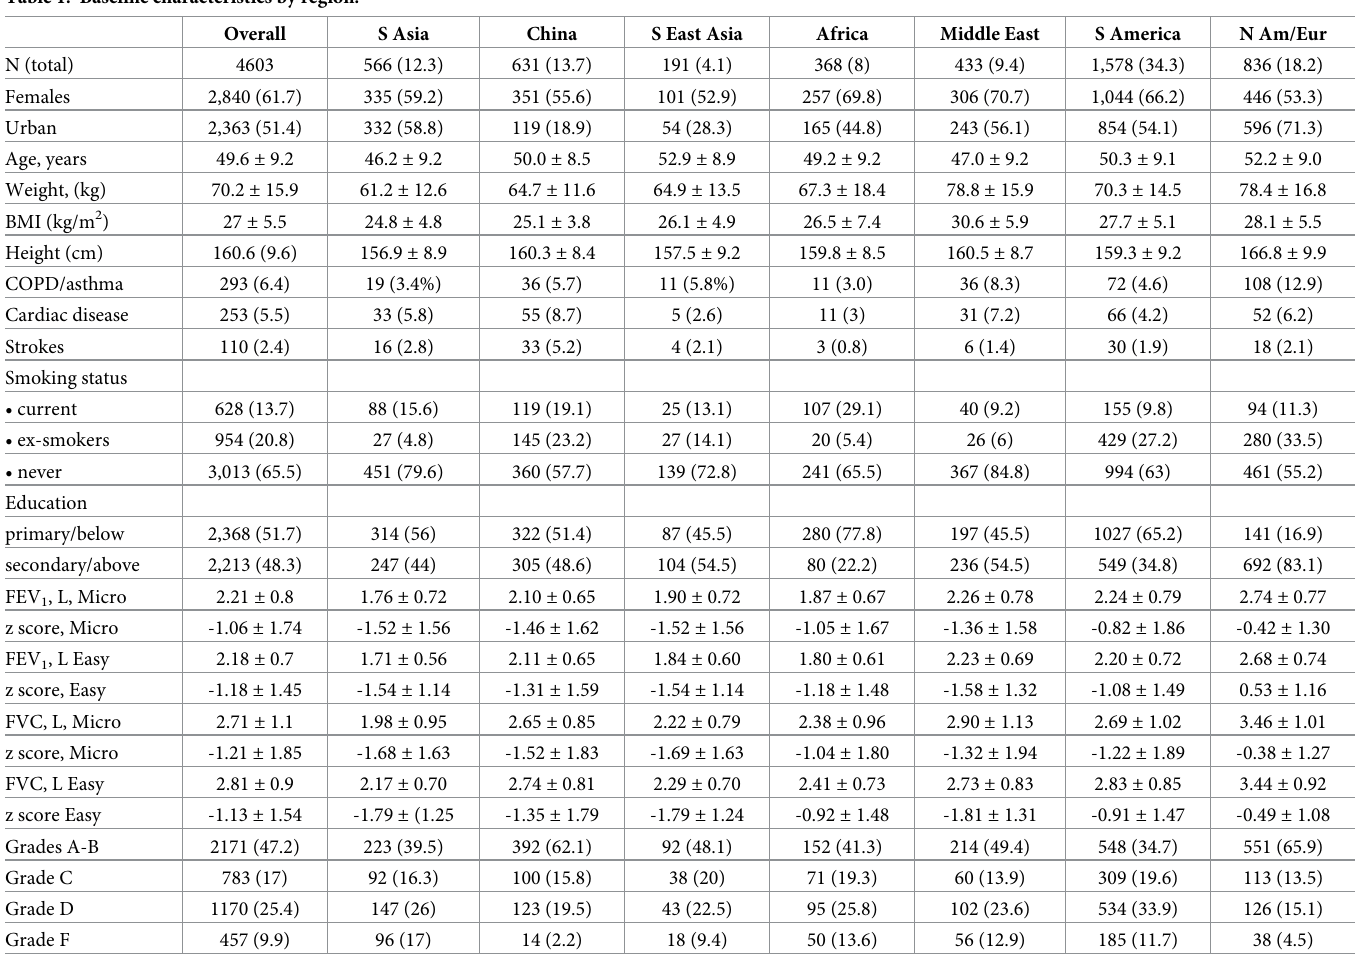
Table 1. Baseline characteristics by